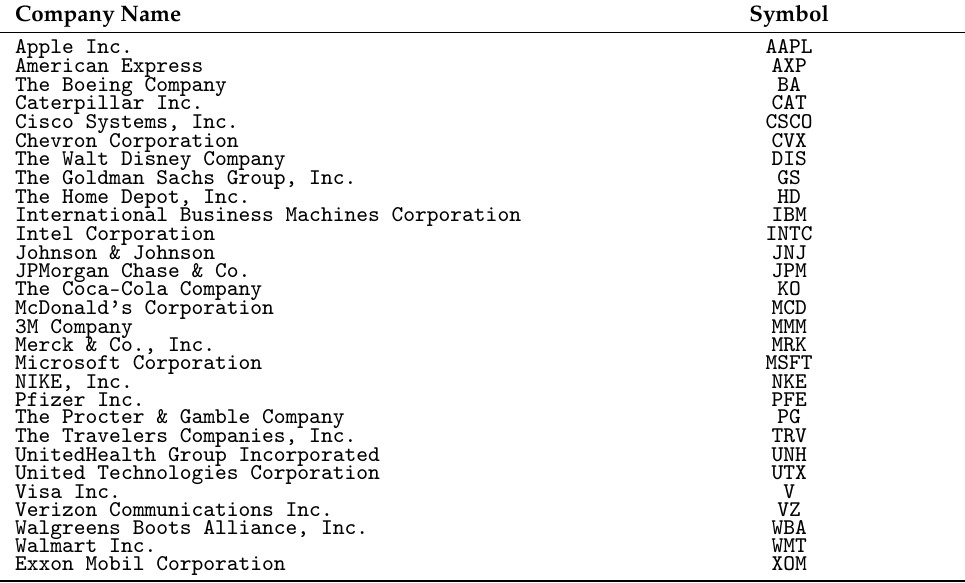
Table 1. List of constituent stocks in DJIA and corresponded